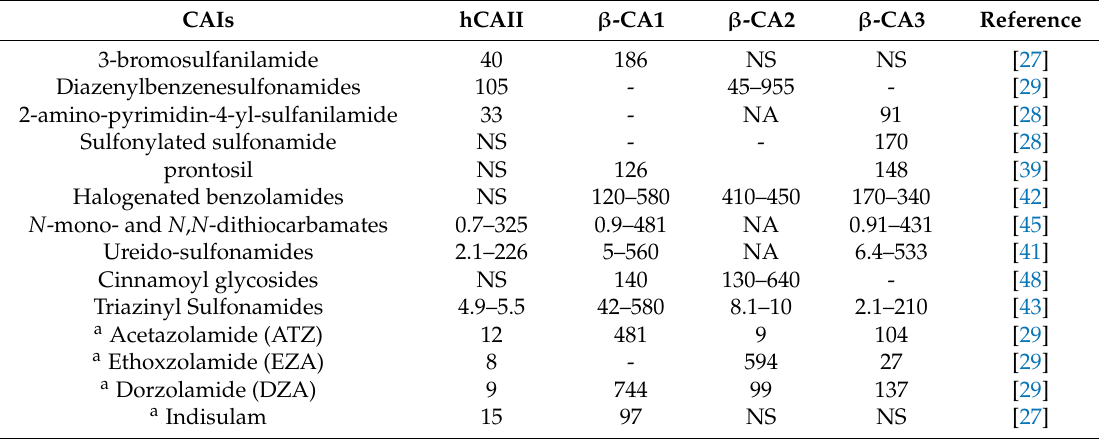
Table 2. Compounds that inhibit M. tuberculosis β -CAs at nM concentrations compared to inhibition of human CAII enzyme in vitro